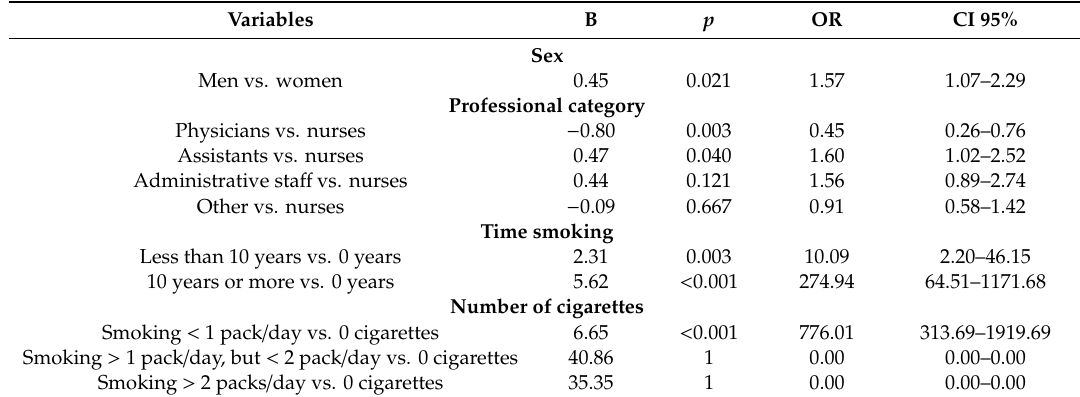
Table 6. Variables associated with smoking. Logistic regression final